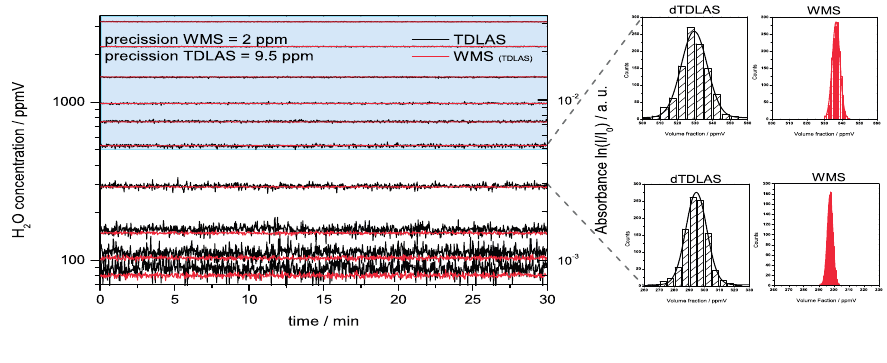
Figure 13. Left side: quasi simultaneous, multiplexed dTDLAS and WMS-2f measurement for several 30 min concentration steps. The blue highlighted area is used to calibrate the WMS-2f/1f signal using dTDLAS. Right side: The measurement noise are clearly Gaussian distributed (right panels), where the WMS results show a fivefold smaller half width of the distribution resulting in better precision in concentration of 2